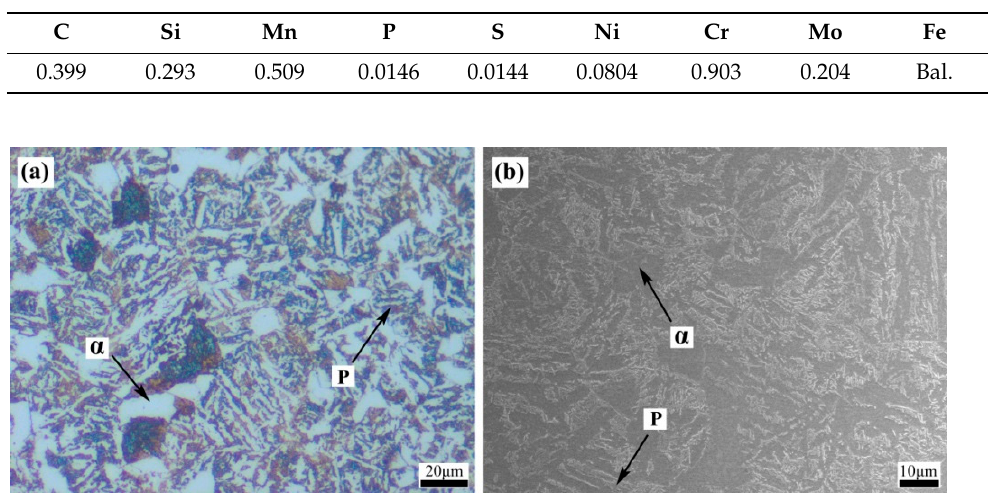
Table 1. Chemical composition of the AISI 4135 steel used in this work (wt.%).